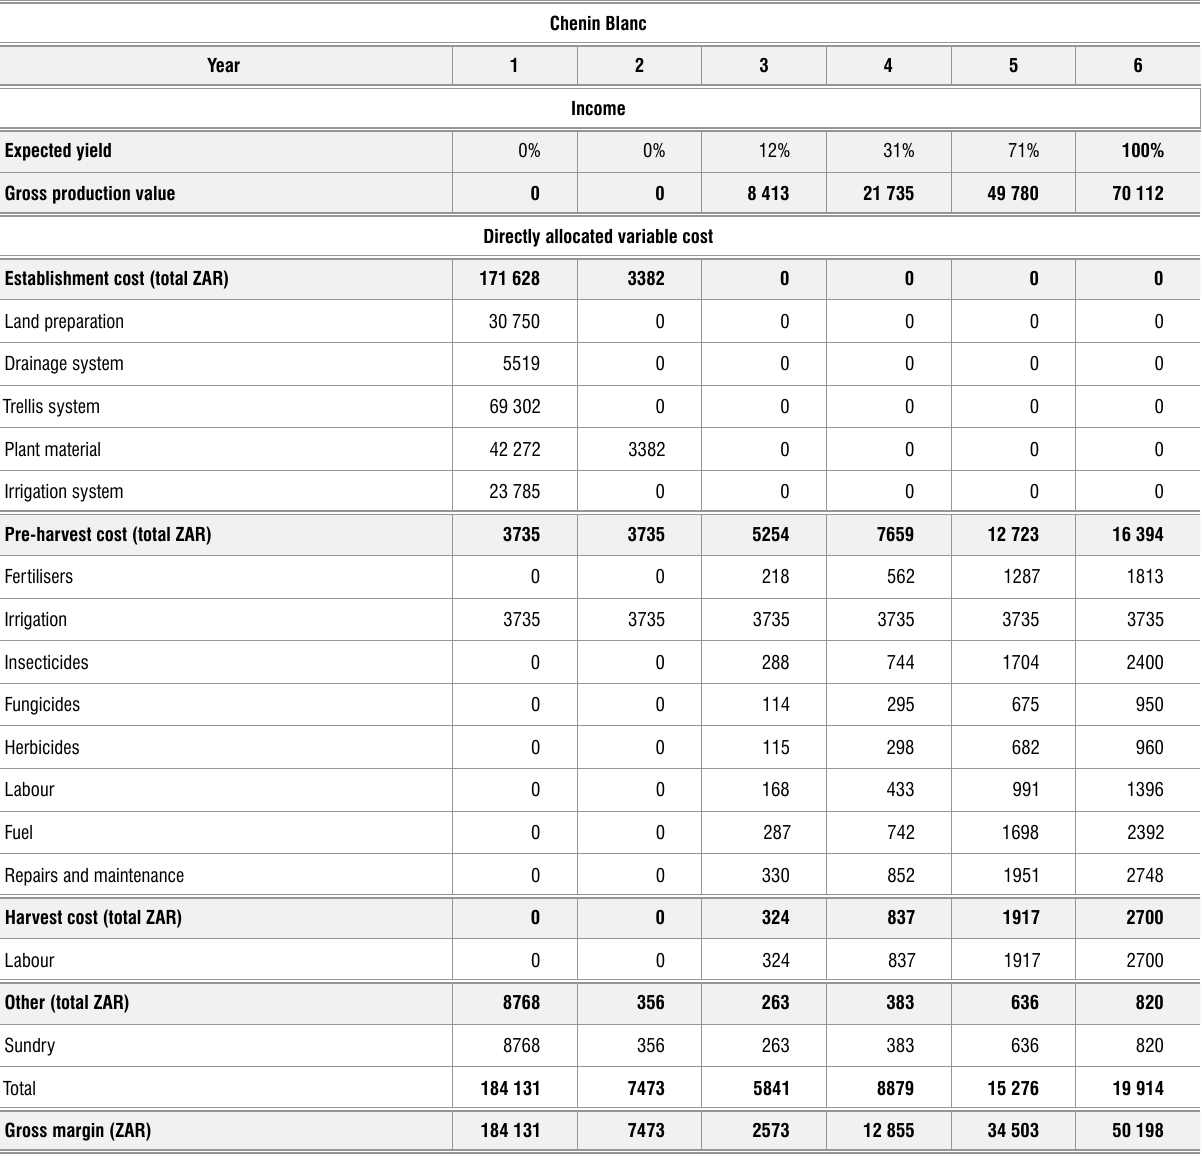
The enterprise budget for Chenin Blanc for